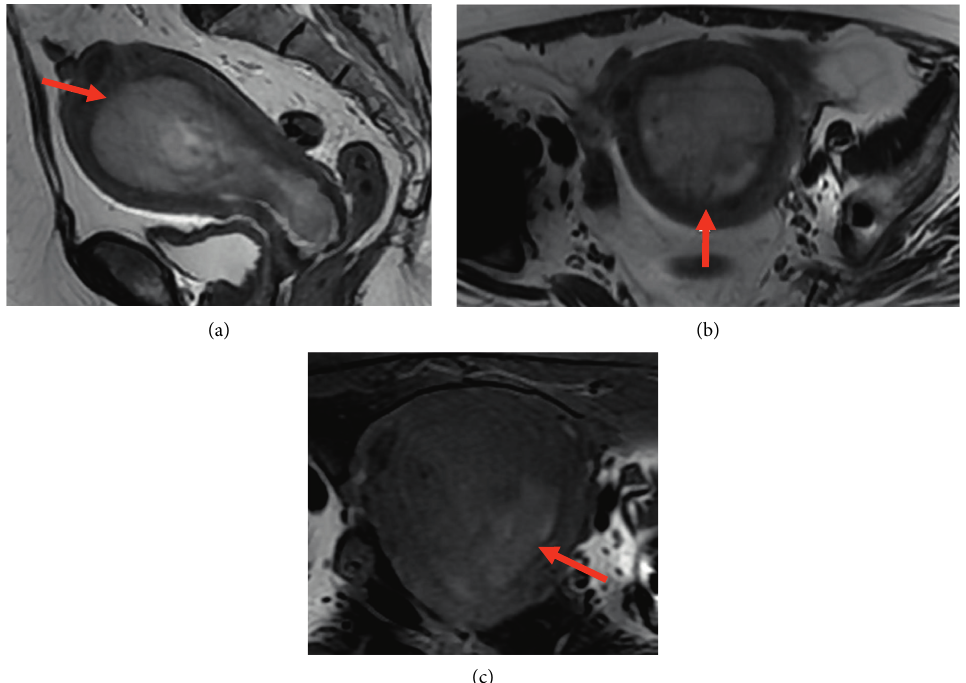
Figure 3: Pelvic MRI of endometrial stromal sarcoma: (a, b, c) sagittal (a) and axial (b) T2WI showing a large intrauterine tumor with heterogeneous intermediate T2 signal with invasion of junctional zone (arrow); and axial T1 Fat-Sat WI (c) showing high signal intensity intratumoral hemorrhage